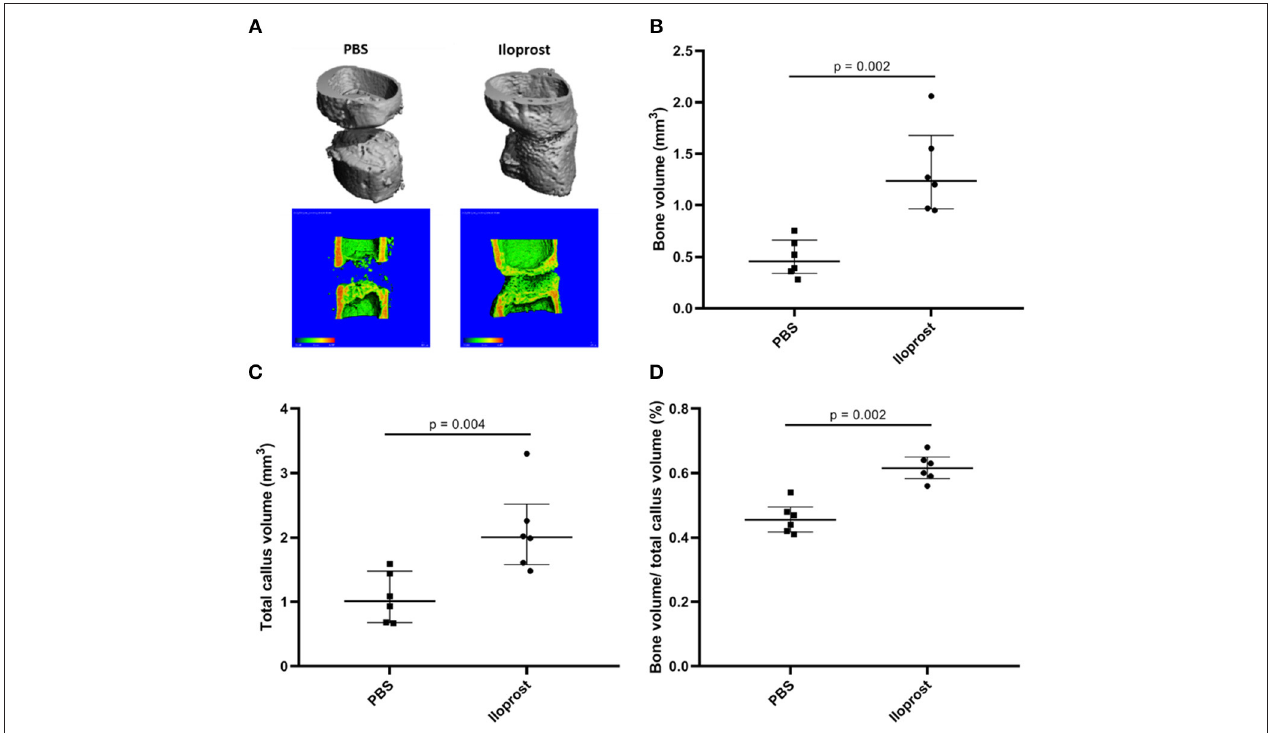
FIGURE 9 | Proof of concept approach of Iloprost to improve bone fracture healing in vivo . µ CT analysis of the healing outcome 21 days post-osteotomy in a mouse osteotomy model. (A) Representative µ CT images of the Iloprost treated (right) and control (left, PBS) group. The upper row shows the 3D reconstruction of the µ CT measurement. In the lower row, 3D reconstruction was cut in the middle to evaluate the healing progression. The color code indicates the mineralization state, increasing from blue to red. (B–D) Quantification of the µ CT results; n =